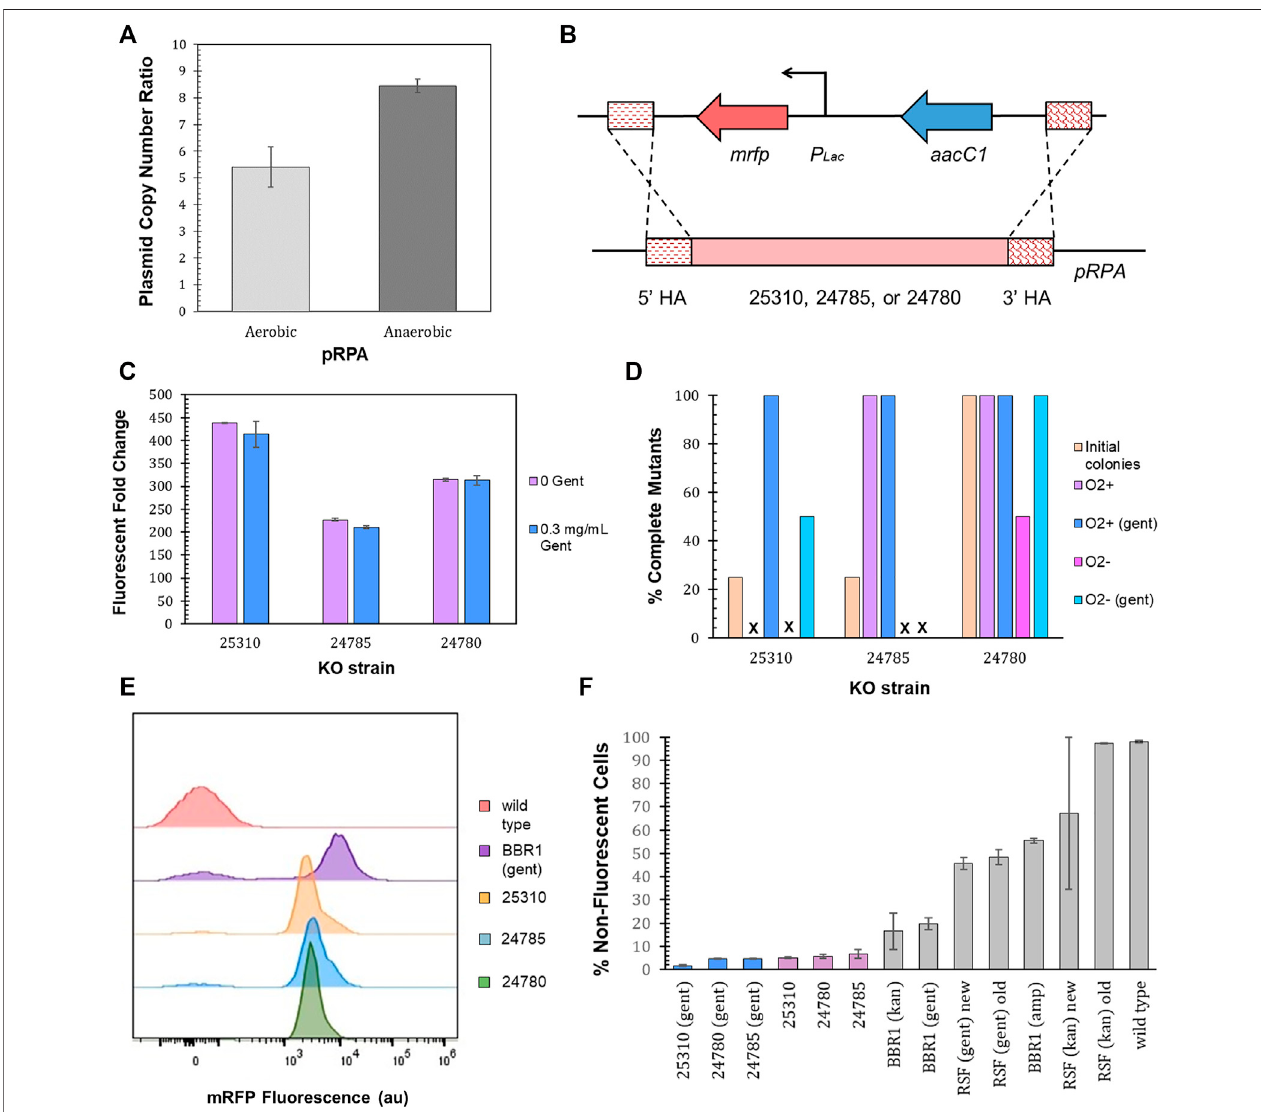
FIGURE 8 | pRPA as a heterologous gene expression vector. (A) Average pRPA copy number for wild type R. palustris grown aerobically in the dark and anaerobically in the light (100 µE white light) in duplicate. Copies of the plasmid ’ s replication protein gene (TX73_RS24750) was compared to the single copy dxs gene in the chromosome by qPCR and an external standard curve (Materials and Methods). Error bars represent the population standard deviation. (B) Schematic of the P Lac -mrfp expression cassette and a gentamicin selection marker integrated into one of three locations, TX73_RS25310, TX73_RS24785, TX73_RS24780, in R. palustris ’ endogenous plasmid, pRPA, by double homologous recombination. (C) Fluorescent fold change average of R. palustris pRPA-25310-mRFP-Gent, pRPA-24785-mRFP-Gent, and pRPA-24780-Gent strains grown in triplicate either without any antibiotic or with 0.3 mg/mlgentamicinsulfate.Thedataisrepresentativeofthe fi rsttestwithnew culturesaswellasthetestafter threerounds ofdilution and regrowth (Materials and Methods). Error bars represent the population standard deviation. (D) Comparison of the percent complete mutants (those that do not produce an